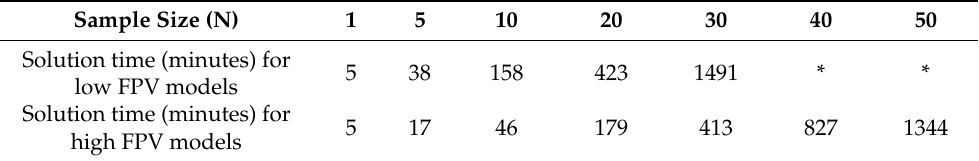
Table 2. Total solution time for conducting 300 runs of the stochastic program using different sample sizes N (i.e., N samples of DFSs). Models were solved by using IBM’s ILOG-CPLEX v.12.6 on a 64-bit workstation equipped with a quad-core 2.53 GHZ processor and 8 GB of memory, with optimality gap set to 1%.